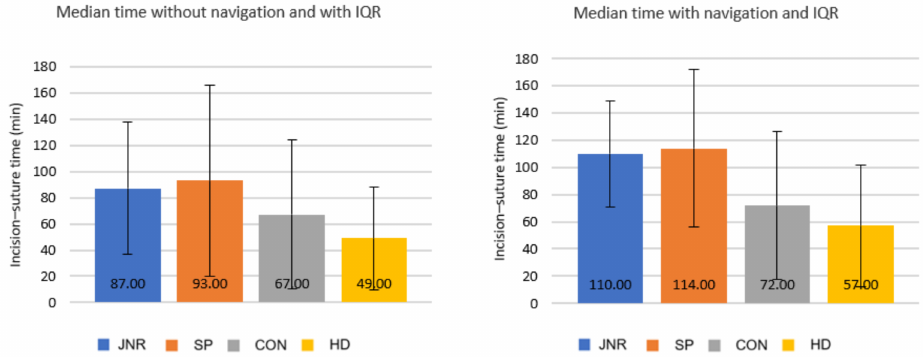
Figure 7. Median time without and with navigation, with interquartile range